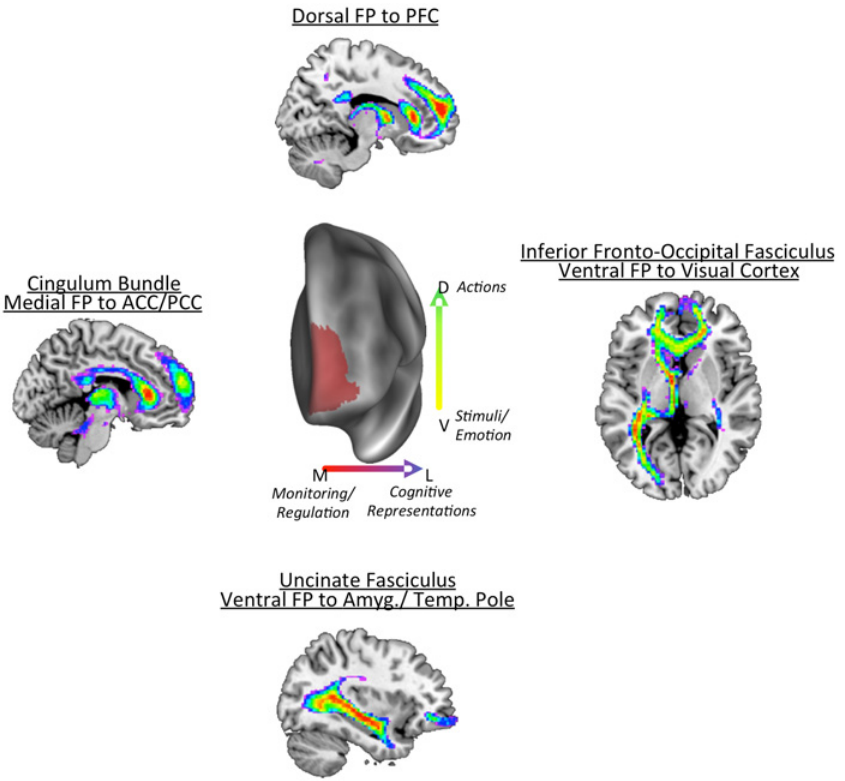
Fig 12. Proposed organizational framework for the frontal pole. We propose that the frontal pole has both a medial-lateral gradient of function as well as a ventral-dorsal gradient of function. Medial areas of FP integrate information from regions involved in monitoring behavior and regulating emotion. Lateral areas (particularly dorsal lateral) connect to posterior PFC regions and to parietal cortex. As such, dorsal lateral areas are involved in maintaining cognitive representations and action plans. Ventral FP connected to regions thought to be involved in linking stimuli to values and